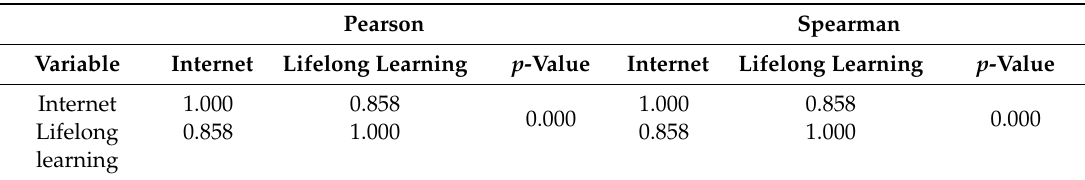
Table 4. Correlation tests.